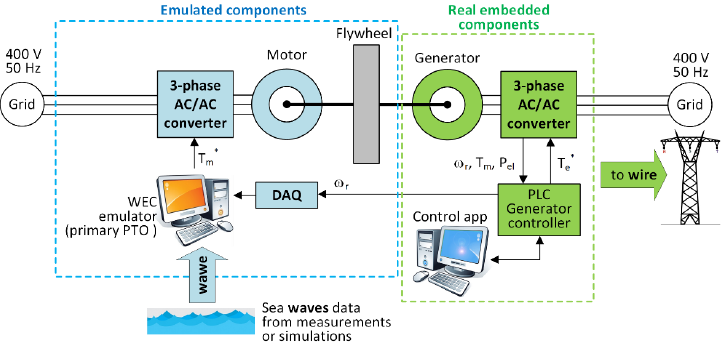
Figure 2. Schematic architecture of the test rig setup.